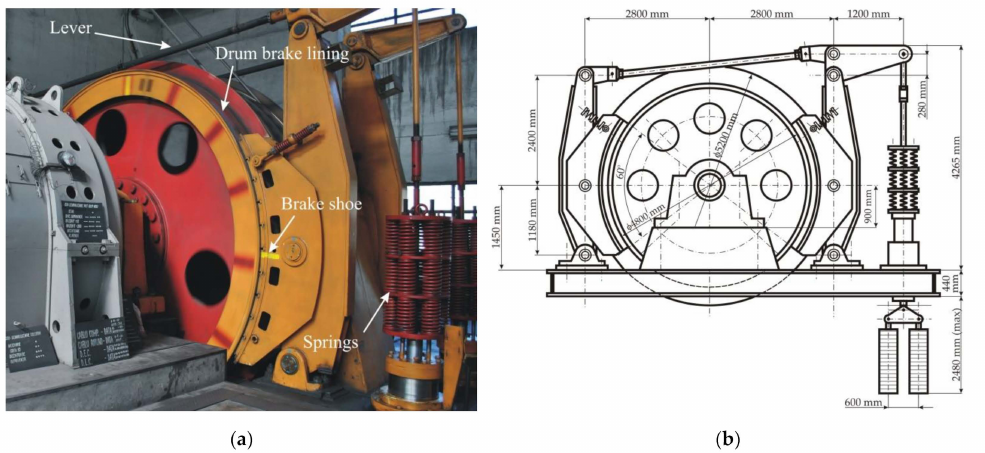
Figure 2. The MK5 × 2 hoisting machine: ( a ) Photo of the drum brake system; ( b ) detailed drawing of the drum brake system